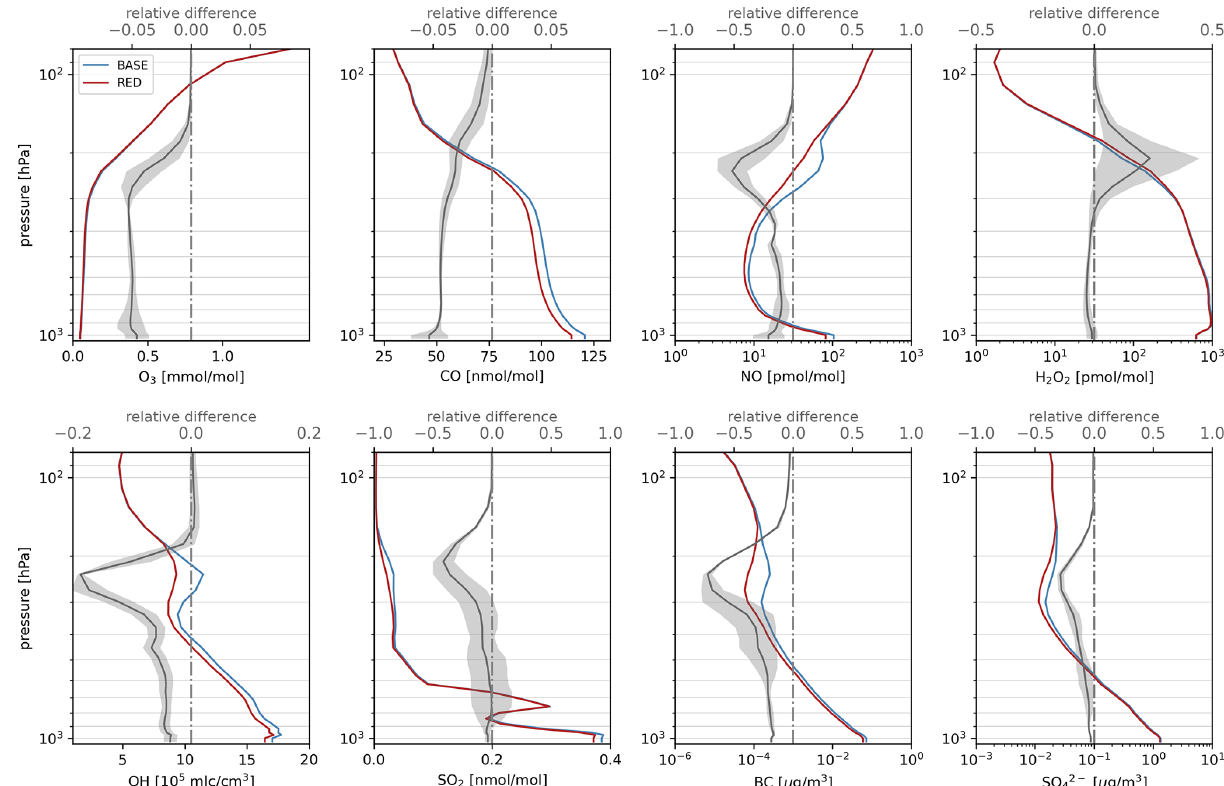
Figure 5. Vertical profiles from BASE and RED simulations and their relative difference ((RED − BASE) / BASE). The grey area represents 1 standard deviation of the spatial–temporal mean (grey line). Please note the different scales for the relative differences.